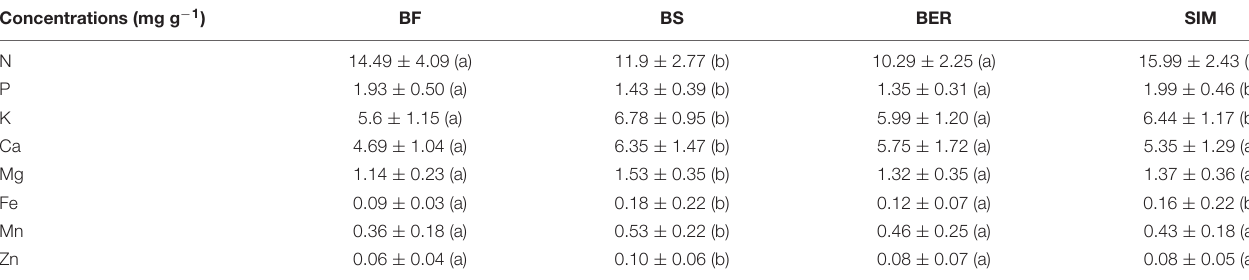
TABLE 4 | Seedlings’ foliar chemistry for balsam fir (BF) and black spruce (BF) at the BER and SIM sites. Concentrations (mg g − 1 )